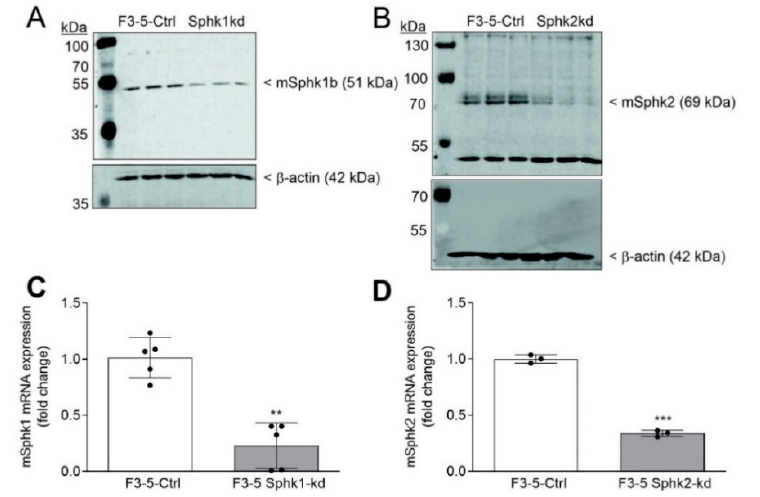
Figure 1. Stable mSphk1- and mSphk2-knockdown in F3-5 cells. F3-5 cells stably transduced with either an empty lentiviral vector (Ctrl) or a lentiviral vector transcribing shRNA targeting mSphK1 (Sphk1-kd), or mSphk2 (Sphk2-kd) mRNA, were incubated for 16 h in serum-free DMEM. Protein ( A , B ) and RNA ( C , D ) were extracted. Proteins were analyzed by immunoblotting using antibodies against mSphk1 ( A , upper panel), mSphk2 ( B , upper panel), or β -actin ( A , B , lower panels). RNA was taken for quantitative PCR analysis using primers for mSphk1 ( C ) and mSphk2 ( D ), and 18S RNA for normalization. Results are expressed as fold change and are means ± S.D. ( n = 5 or 3). ** p < 0.01, *** p < 0.001 considered statistically significant when compared to the control cells. Knockdown (kd) cells were exposed for 6 h to normoxia (21% O 2 ) or hypoxia (1% O 2 ). In control (Ctrl) F3-5 cells, hypoxia typically upregulated Epo protein levels when com- pared to normoxia controls. This hypoxia effect was abolished in Sphk1-kd cells (Figure 2A), while it was upregulated in Sphk2-kd cells (Figure 2B). Notably, a band at 35–40 kDa is also detected by the anti-Epo antibody, which likely represents a higher glycosylated intracellular form of Epo [45]. HIF-2 α , the key transcription factor regulating Epo tran- scription in hypoxia, was regulated in a similar manner, i.e., hypoxia-induced HIF-2 α pro- tein levels were reduced in Sphk1-kd, but upregulated in Sphk2-kd. Notably, HIF-2 α was already increased in normoxic Sphk2-kd cells. Figure 2: Sphk1- and Sphk2-knockdown in F3-5 cells affects hypoxia-induced HIF-2 α protein and Epo mRNA and protein levels. Control F3-5 cells (Ctrl), or cells stably downregulating mSphk1